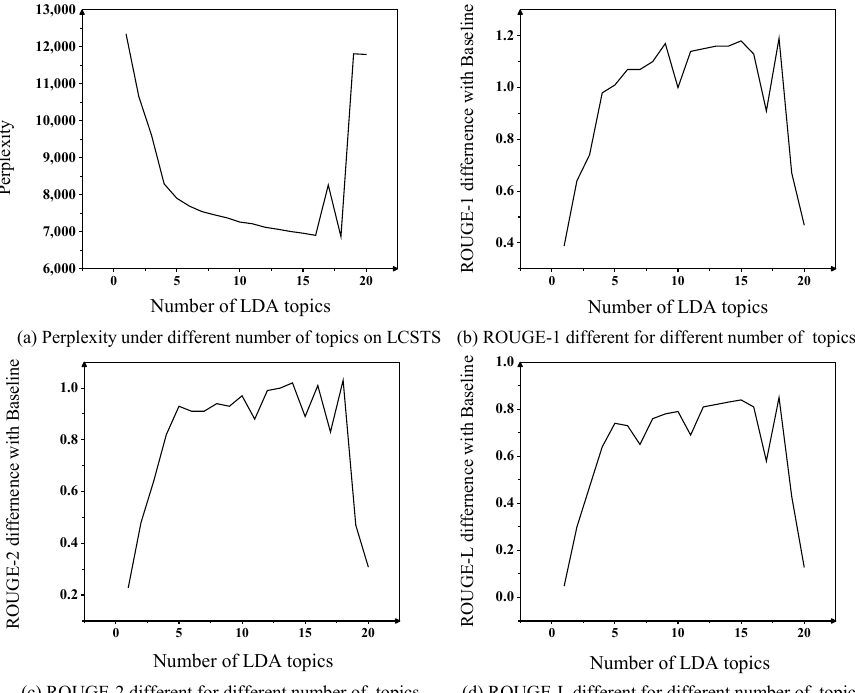
Figure 8. Correlation of summary quality with the number of topics in LCSTS dataset, where, figure ( a ) shows the variation of perplexity with the number of topics.In figure ( b – d ), the vertical axis represents the ROUGE difference between ACGT and the baseline model [4].